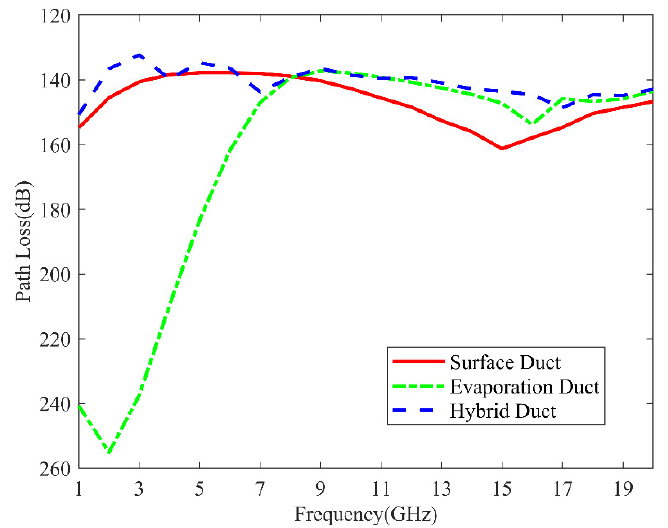
Figure 15. Microwave propagation path loss at different frequencies with a receiving height of 5 m and a receiving distance of 200 km.